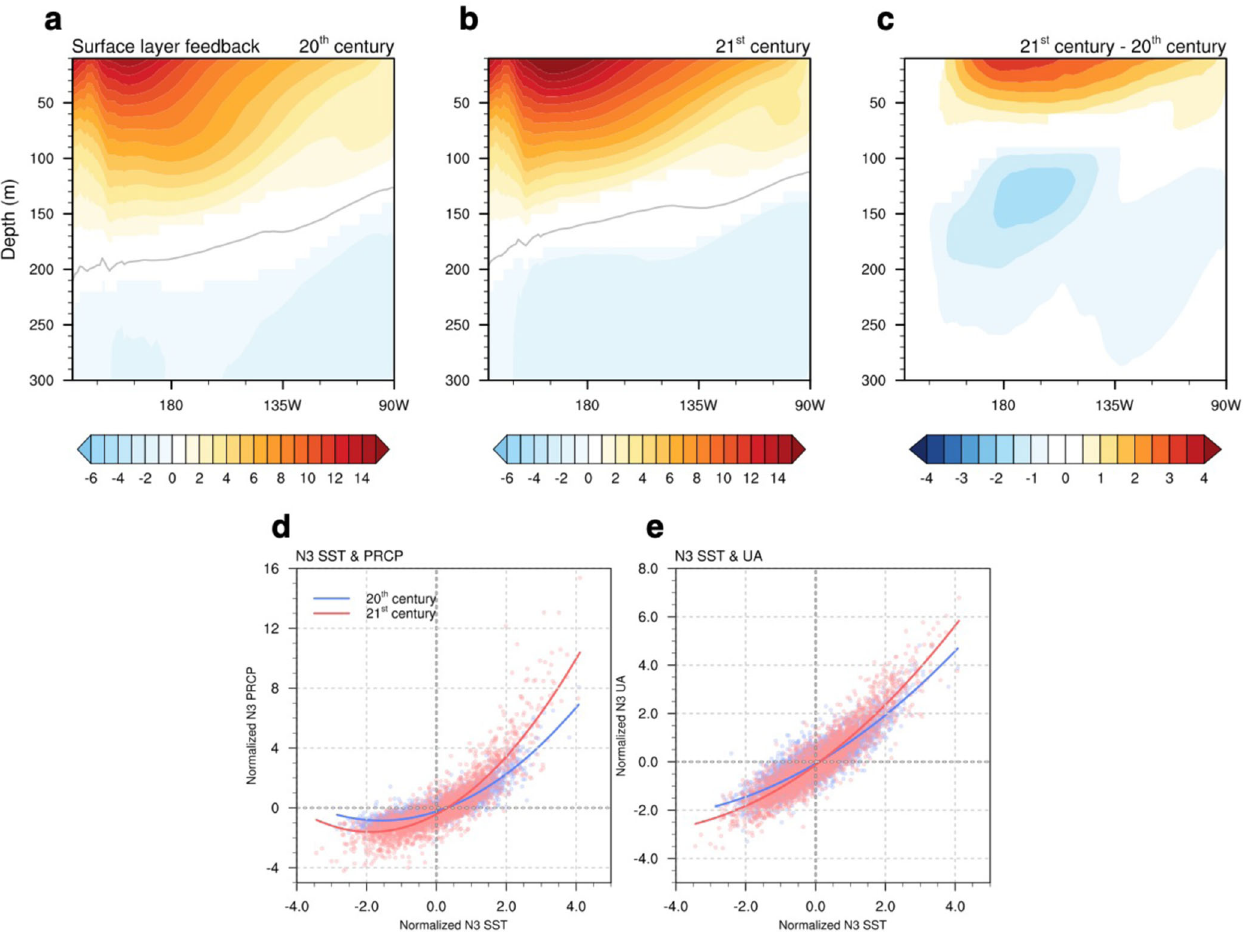
Fig. 4 Enhanced surface-layer feedback and increased nonlinear atmospheric feedback. The equatorial averaged (5 ° S – 5 ° N) zonal current anomalies in response to the zonal-mean (5°S – 5°N, 120°E – 90°W) zonal windstress anomalies for the 20th century ( a ) and 21st century ( b ), respectively. Gray lines indicate the zero-line. Difference in zonal current response between the 20th and 21st centuries ( c ). Shadings indicate a 95% con fi dence level using the bootstrap method (Methods). The units are [m 3 N − 1 s − 1 ] for ( a – c ). Scatter plots between precipitation anomalies and Niño3 SSTA ( d ) and between 850 hPa zonal wind anomalies and Niño3 SSTA ( e ) in the 30 CMIP6 models. Each variable is normalized by the 20th-century STD for each model. Blue and red colors represent the 20th and 21st centuries,